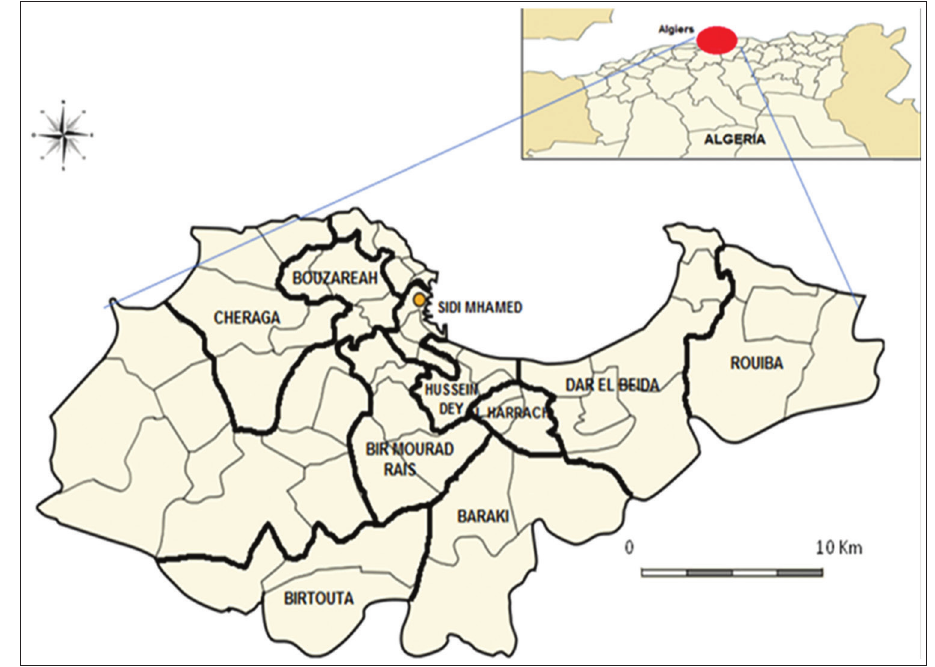
Figure-1: Geographical distribution of the study areas consist of the sampling sites in ten departments (More than 40 municipalities) of Algiers, capital of Algeria (230 butchers sampling). Source: Personalized map (Based on geographic delineation maps provided by Algiers